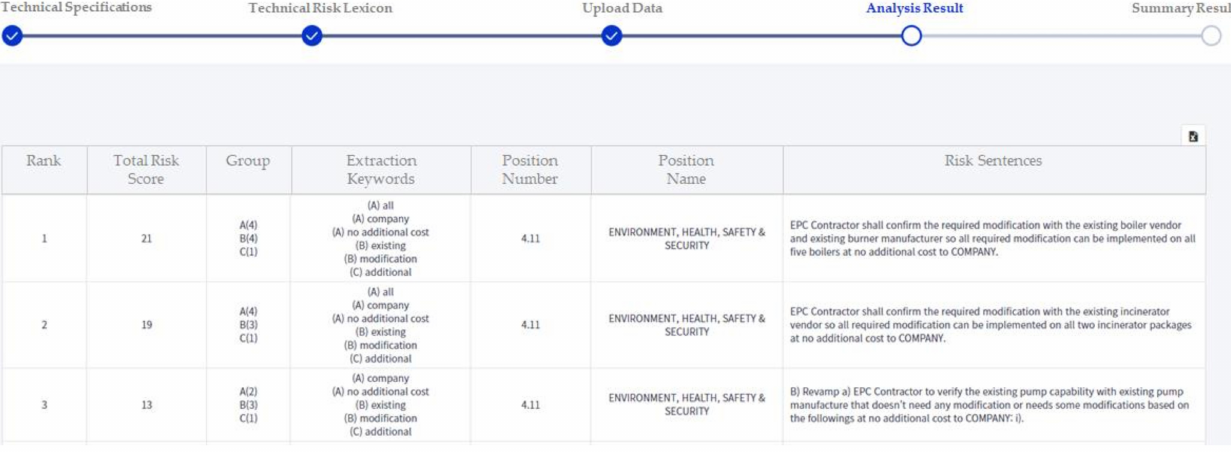
Figure 10. TRE analysis result